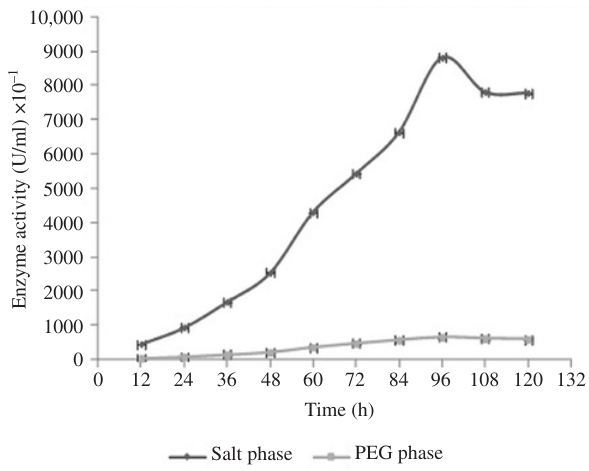
Figure 1: Enzyme production kinetics of Aspergillus niger in a shake flask at pH 4.0 and temperature of 30 ° C.